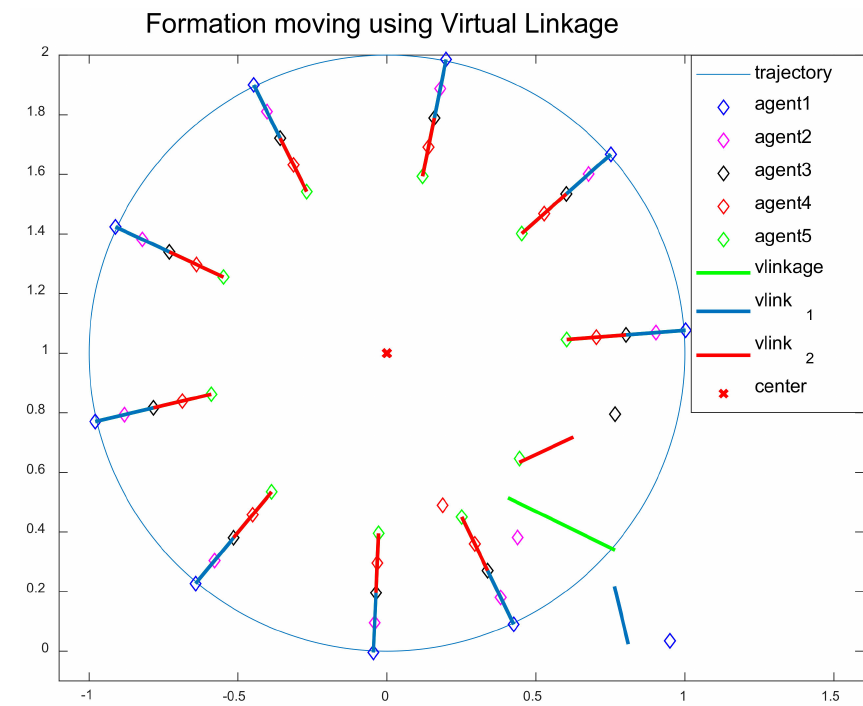
Figure 19. Snapshots of the formation moving.